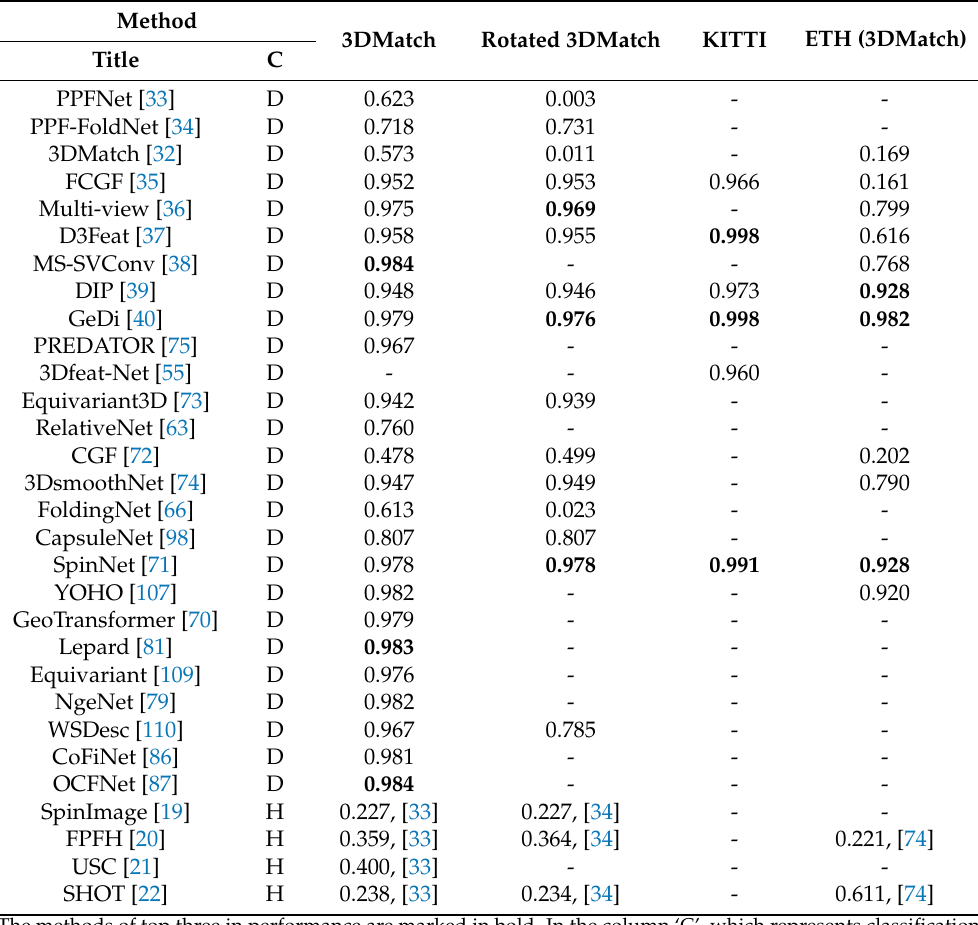
Table 2. FMR on the four benchmark